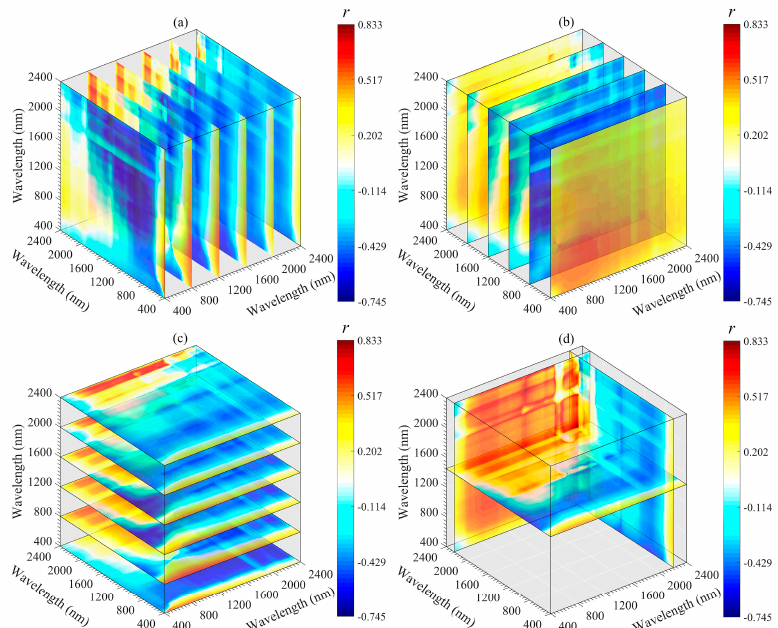
Figure 6. Three-dimensional slice maps of correlations between SOM content and TBI1 based on calibration set ( n = 112). ( a – c ) represent slice maps based on the x -axis, y -axis, and z -axis, respectively, and ( d ) represents the optimal slice map.